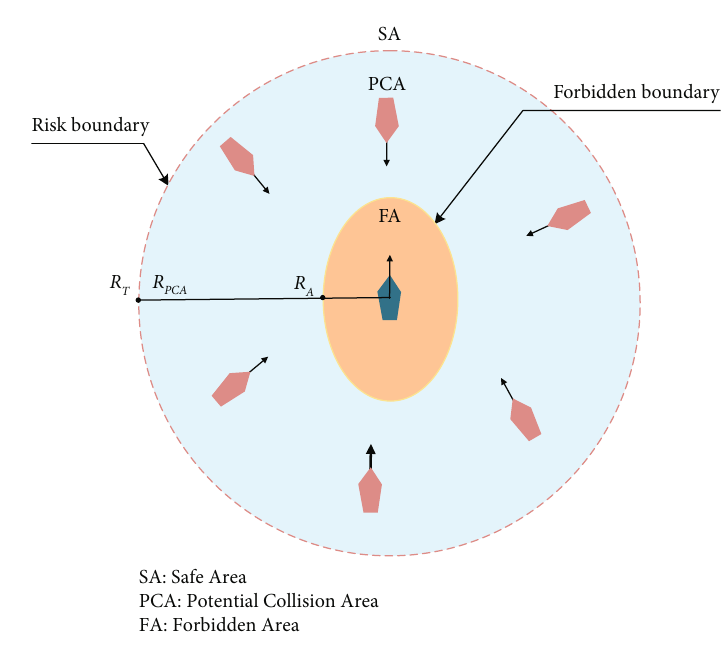
Figure 4: Risk area around the